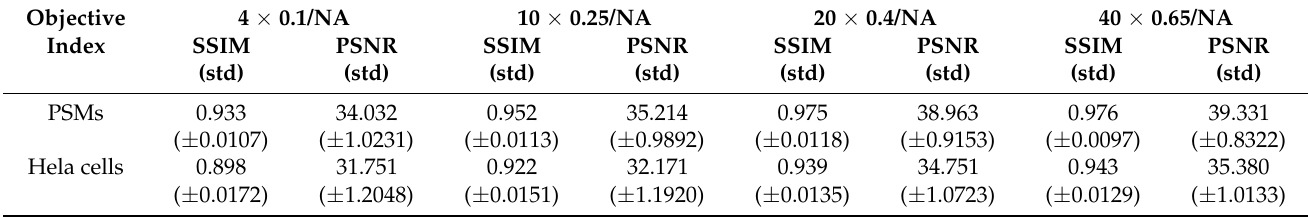
Figure 8. Test results of Hela cells by the ContransGAN-Hela. Amplitude represents the LR micro- scopic images; ground truth represents the HR quantitative phase images reconstructed by TIE; output represents the output images of the ContransGAN-Hela; SSIM and PSNR reflect the quantitative relationship between the ground truth and output; the dotted frame below is the three-dimensional visual phase distribution in the corresponding FOVs. Table 1. Quality evaluation index of the test output image of different types of